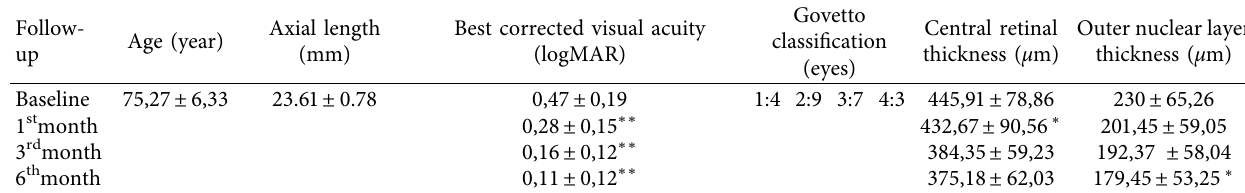
Table 1: Patients’ demografical and anatomical